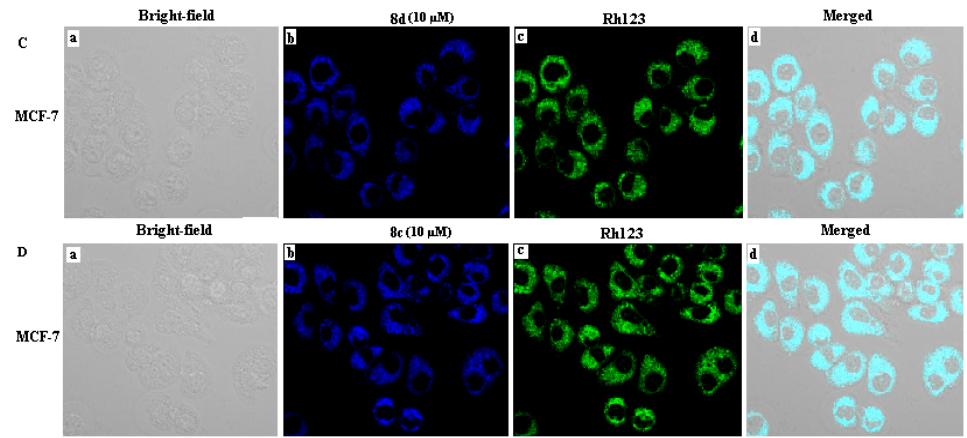
Figure 2. Confocal laser scanning microscopic images of cancer cells treated with 8c or 8d in the presence of Rh123 (0.5 µ M, 20 min) in PBS bu ff er. ( A ) Fluorescence images of HepG2 cells stained with 8d (5 µ M). ( B ) Fluorescence images of HepG2 cells stained with 8d (10 µ M). ( C ) Fluorescence images of MCF-7 cells stained with 8d (10 µ M). ( D ) Fluorescence images of MCF-7 cells stained with 8c (10 µ M). ( a ) Cell images in bright-field. ( b ) Fluorescence images of cells stained with 8c or 8d . ( c ) Fluorescence images of cells stained with Rh123. ( d ) Merged images of ( b ) and ( c ). All images were acquired under a 20 × objective lens.